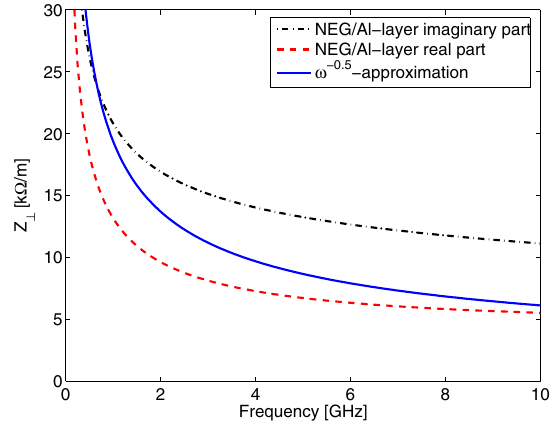
FIG. 5. (Color) Comparison of the ! (cid:2) 0 : 5 approximation with the true imaginary and real part of the resistive wall impedance of a NEG = Al double